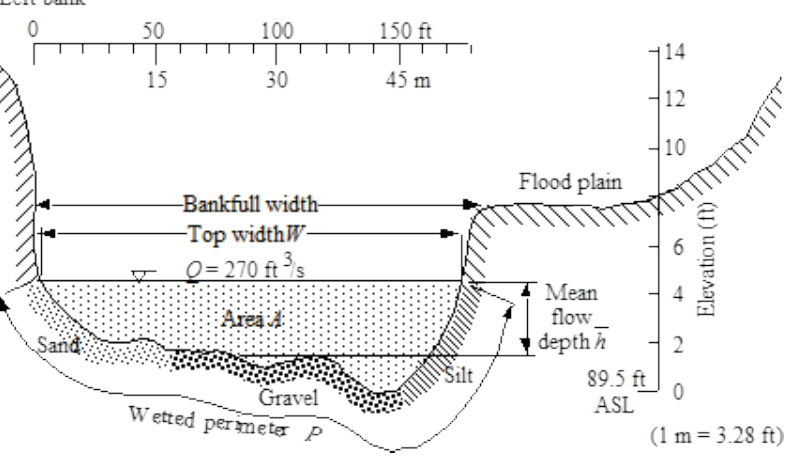
Fig. 1 Example of cross-section geometry from Julien